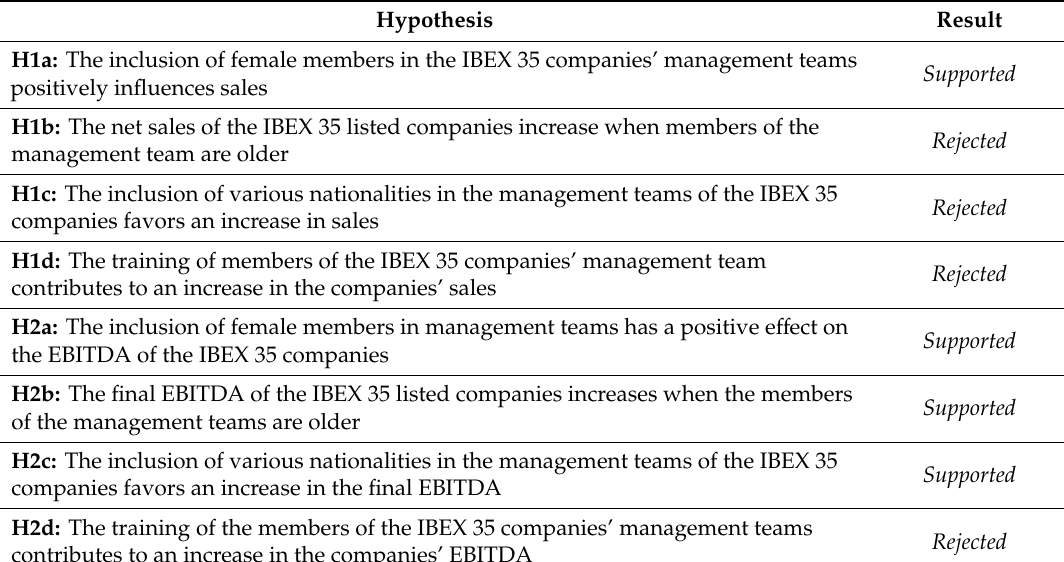
Table 5. Comparison of the results of the